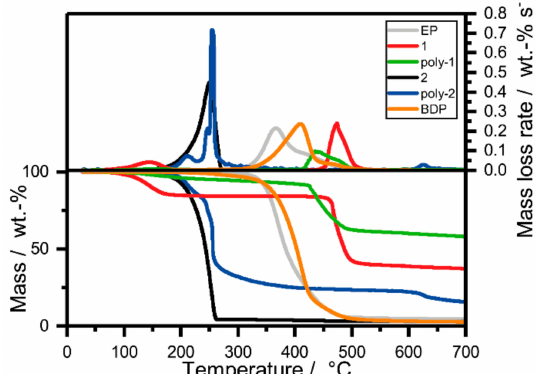
Figure 3. Top: Mass loss rate over temperature of pure flame retardants and the pure epoxy resin. Bottom: Pyrolysis investigations via thermogravimetric analysis (TGA; 10 K min − 1 ; N 2 ); increase of residue yield from aliphatic to aromatic and from monomeric to